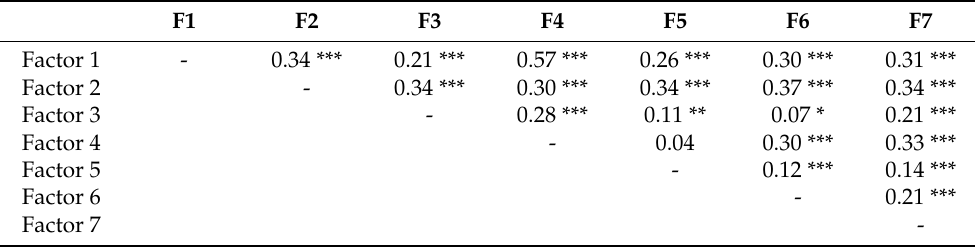
Table 3. Correlation matrix among the seven factors (Sample 1, N =